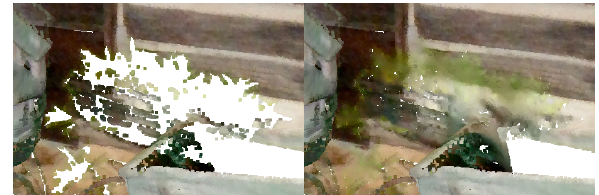
Figure 8. Color leaks in the Stairs segment. The input point cloud (left) has greenish tint around the occluded region because of projected colors captured by the RGB camera. In the inpainting result (right) the same tint has been propagated to the generated